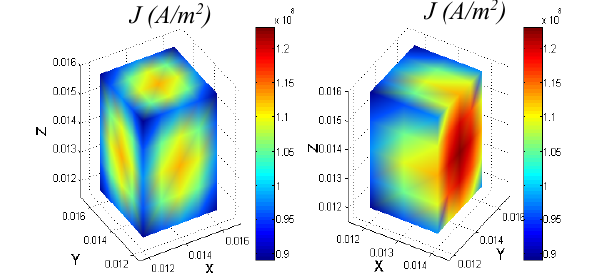
Figure 4 : Current density distribution of the J in the pellet A at t=0.06 S .